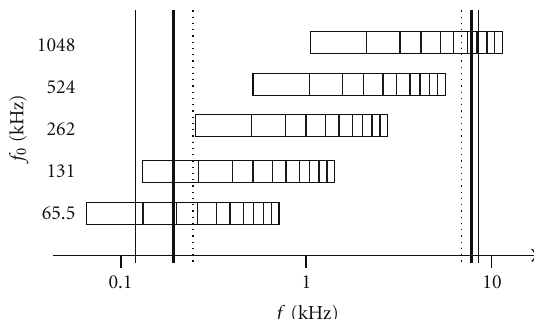
Figure 2: Amplitude spectrums of the f 0 = 65 . 6Hz, 131Hz, 262Hz, 524Hz, and 1048Hz stimuli with ten harmonics with respect to the maximal (thin line) and minimal frequency range (thick line) of the CI speech processors as well as the frequency spectrum of the Baha Intenso device (dotted line). The spectra of the f 0 = 65 . 6Hz, f 0 = 131Hz, and f 0 = 1048Hz tones are not fully covered by the transmission spectra of the CI and the Baha